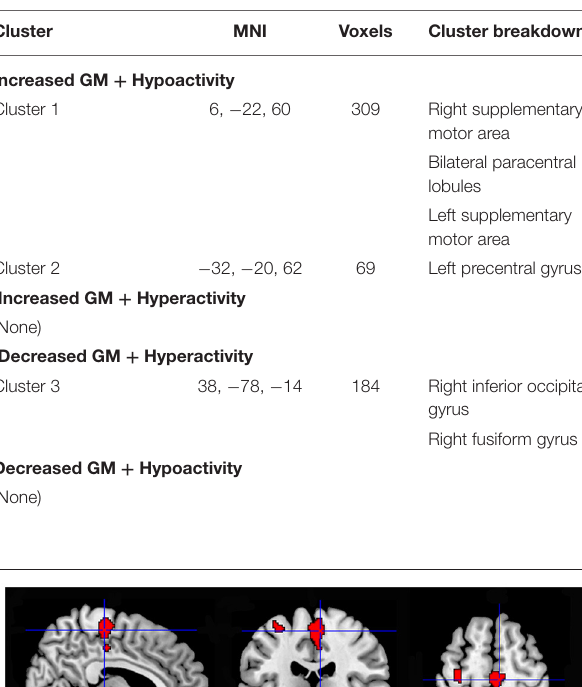
TABLE 5 | Multimodal structural and functional abnormalities in patients with idiopathic blepharospasm compared with healthy controls.